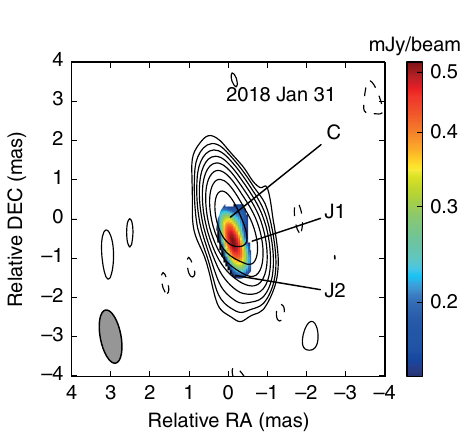
Fig. 2 Linear polarisation image (coloured scale) of J0906 + 6930. The images are derived from the 15-GHz VLBA observation on 31 January 2018. The core is denoted by C and jet components by J1 and J2. The contours represent Stokes I intensity, same as Fig. 1e. The coloured scale denotes the strength of the linear polarisation. The grey-shaded ellipse in the bottom left corner is the restoring beam. The peak of the polarised intensity, ∼ 0.6mJy beam − 1 , is about 0.8 mas southwest of the total intensity core. The maximum fractional polarisation is ~10% appearing at the southernmost of the polarised component. The core region is weakly polarised. This is the only polarisation measurement in a radio-loud quasar at redshift >5 so